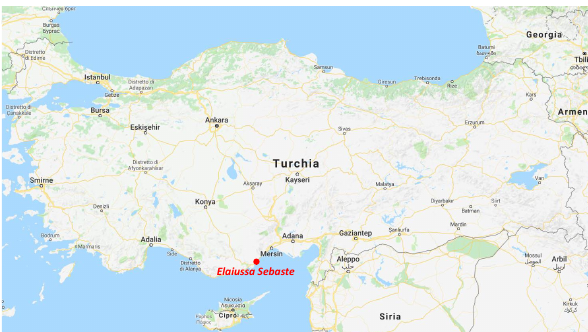
Figure 1. The position of the archaeological site of Elaiussa Sebaste.